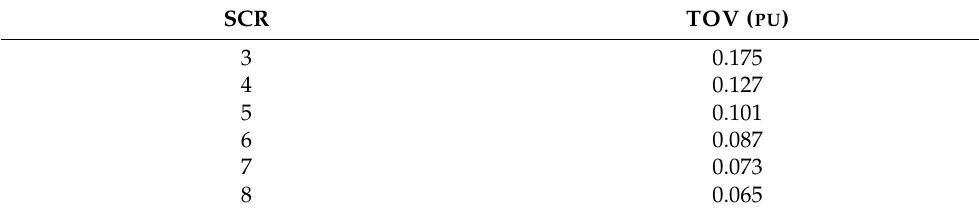
Table 3. Values of TOV when monopolar is blocked.